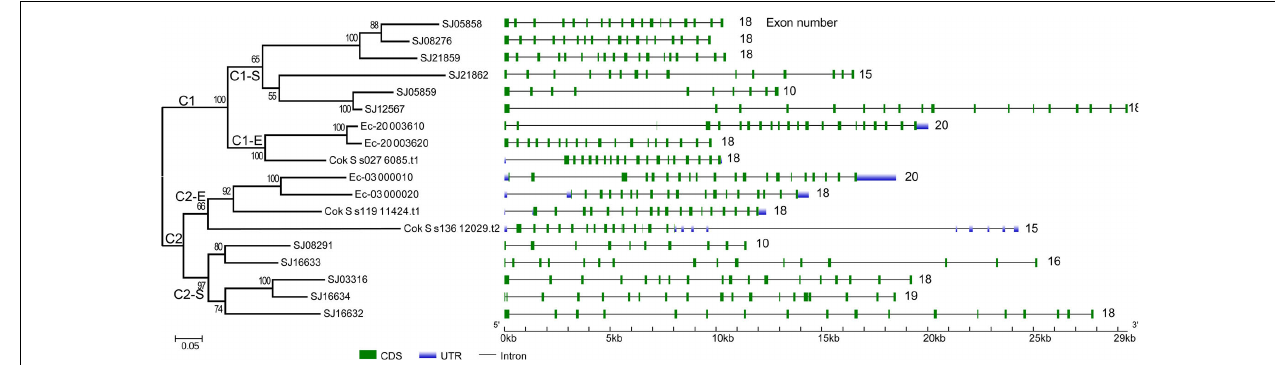
FIGURE 2 | Phylogenetic relationship and gene structure of brown algal LOX genes. The phylogenetic tree was constructed by the ML method with 1000 bootstrap replicates. The two LOX clades were designated as C1 and C2, in which the subclades were designated as C1-S, C1-E, C2-S, C2-E, respectively. Exons and introns are represented by green boxes and black lines, respectively.